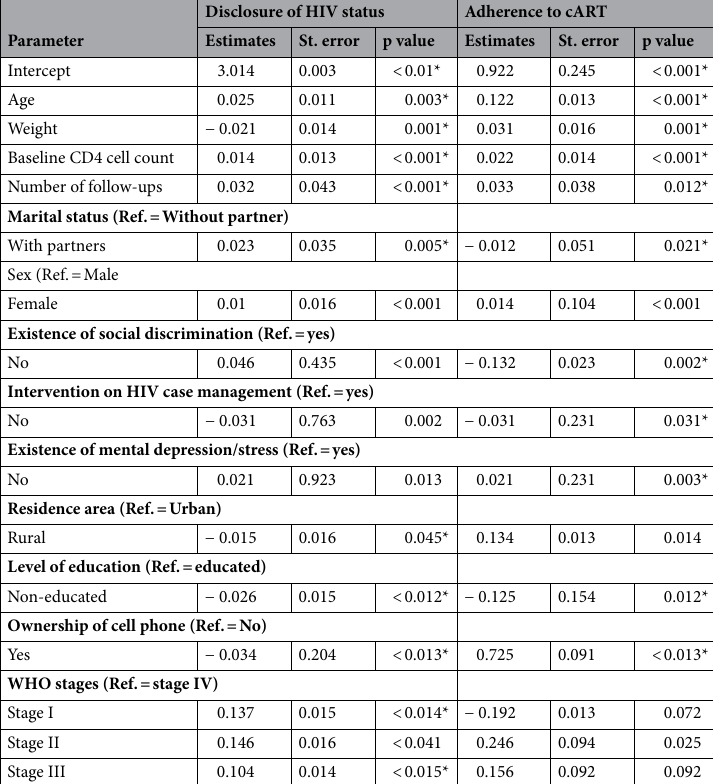
Table 3. Parameter estimates for conditional independence of random intercepts model with disclosure of HIV status data and adherence to cRRT data. *Significant at 95% CI for both